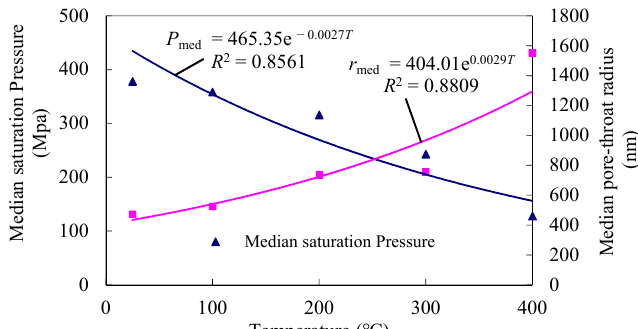
Figure 7. Median saturation pressure and median pore–throat radius curves of granite at different temperatures.